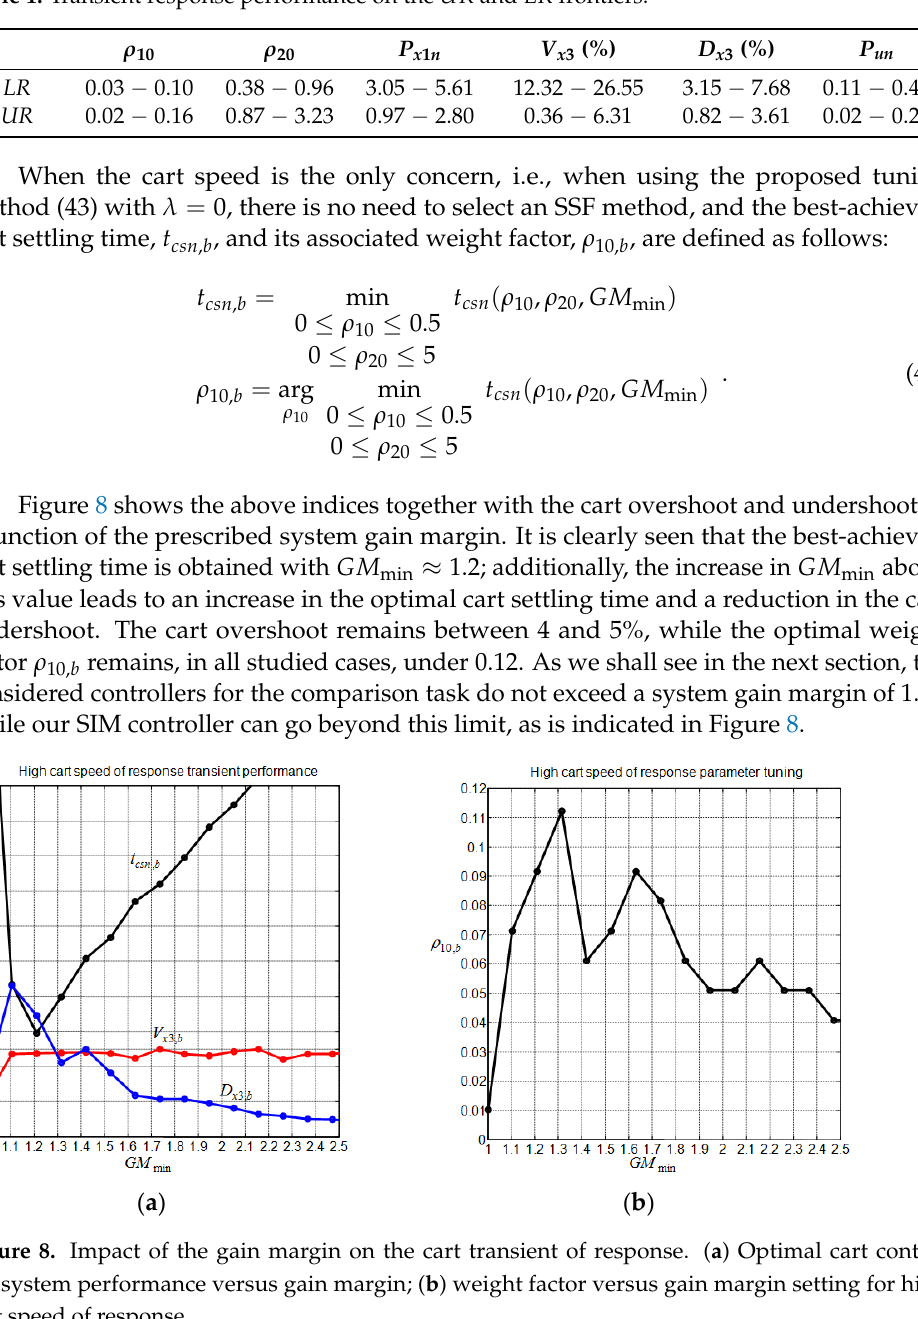
Table 1. Transient response performance on the UR and LR frontiers.